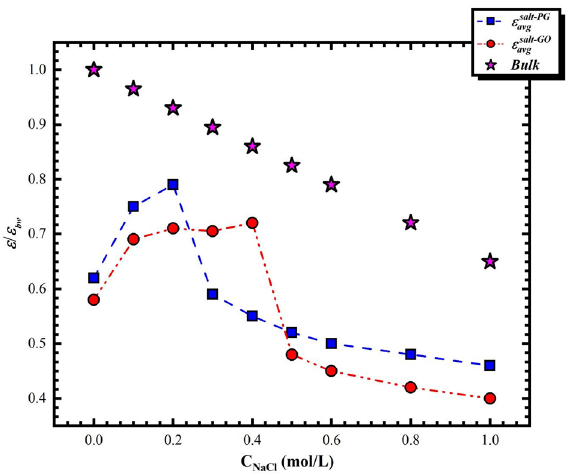
Figure 4. Average dielectric permittivity of confined NaCl solution ( ε salt avg ) and that of in bulk phase (pentagram symbol) as a function of c NaCl